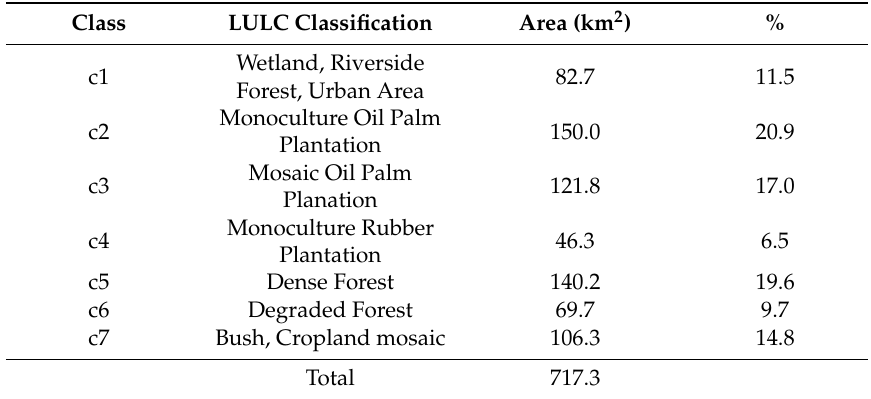
Table 1. Area coverage of each Land-Use and Land-Cover (LULC) in Kudat